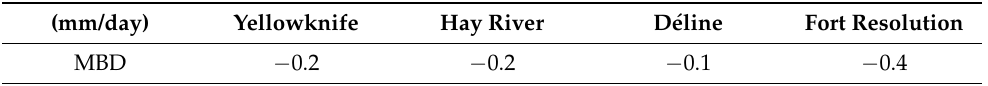
Figure A1. Comparing the 1980-2005 daily November precipitation by computing the mean bias difference between model simulations driven by CANESM2 and ERA_Interim. Table A1. Values of mean bias difference for each community’s daily November precipitation during the 1980 to 2005